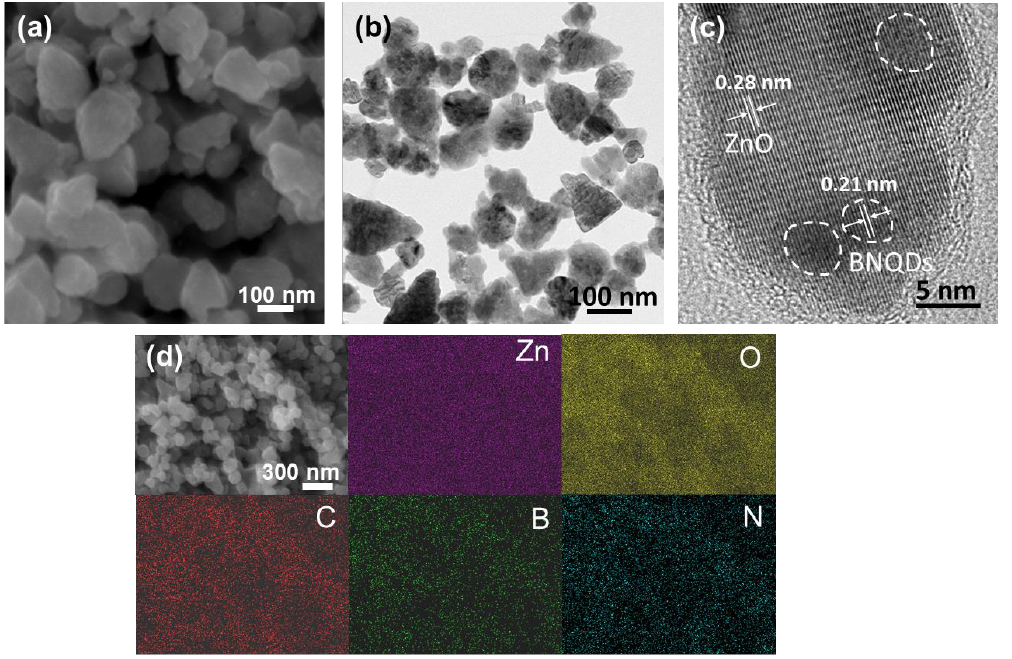
Figure 2. ( a , b ) FESEM and TEM images of the Zn/BNQD nanocomposite and ( c ) its high-resolution TEM image. ( d ) EDS mapping images of Zn/BNQD.